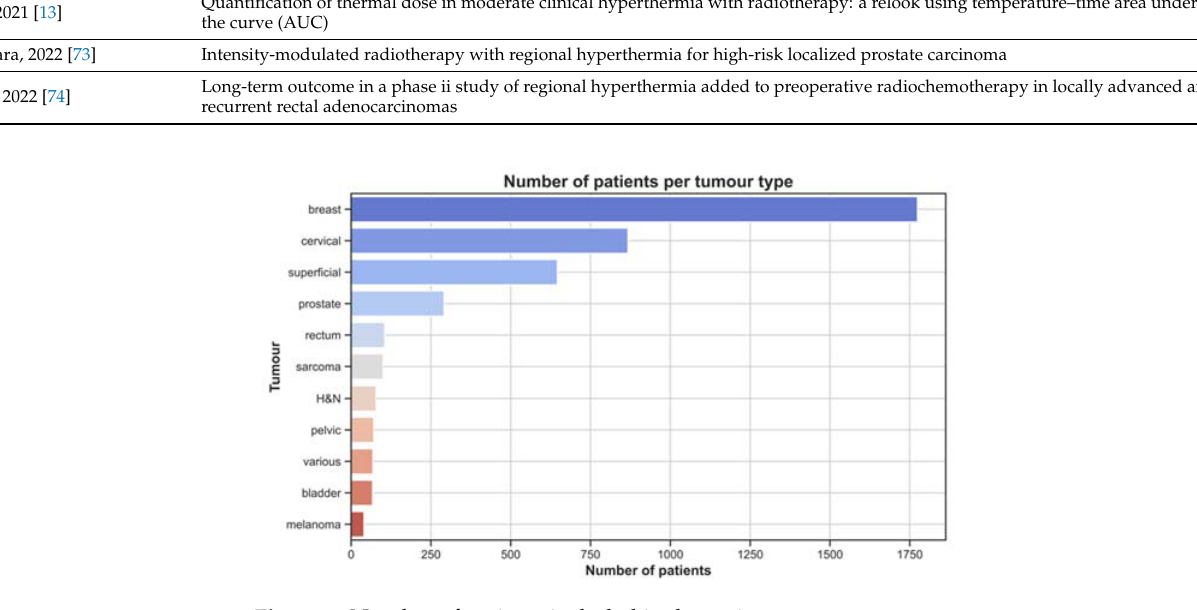
Figure 3. Number of patients included in the review per tumour type.